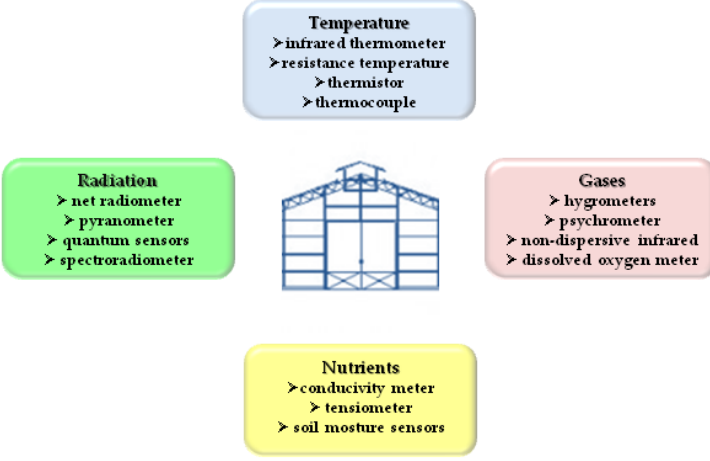
Figure 1. Sensors monitoring the environmental and nutritional conditions of plants in protected environments. Detailed description is reported in Both et al. [88].